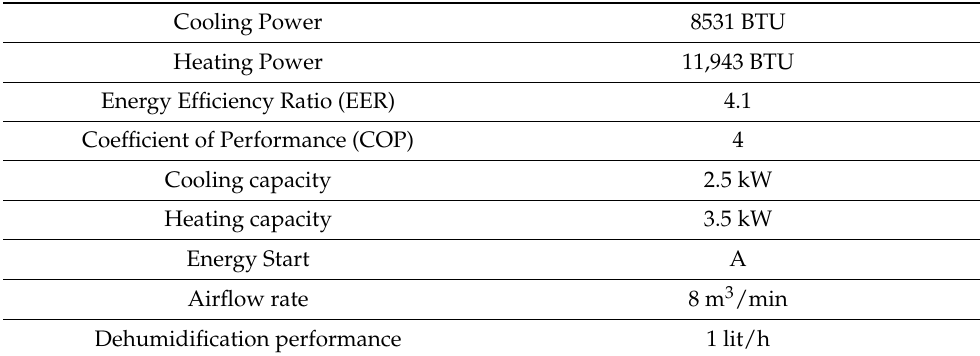
Table 1. Technical characteristics of the A/C